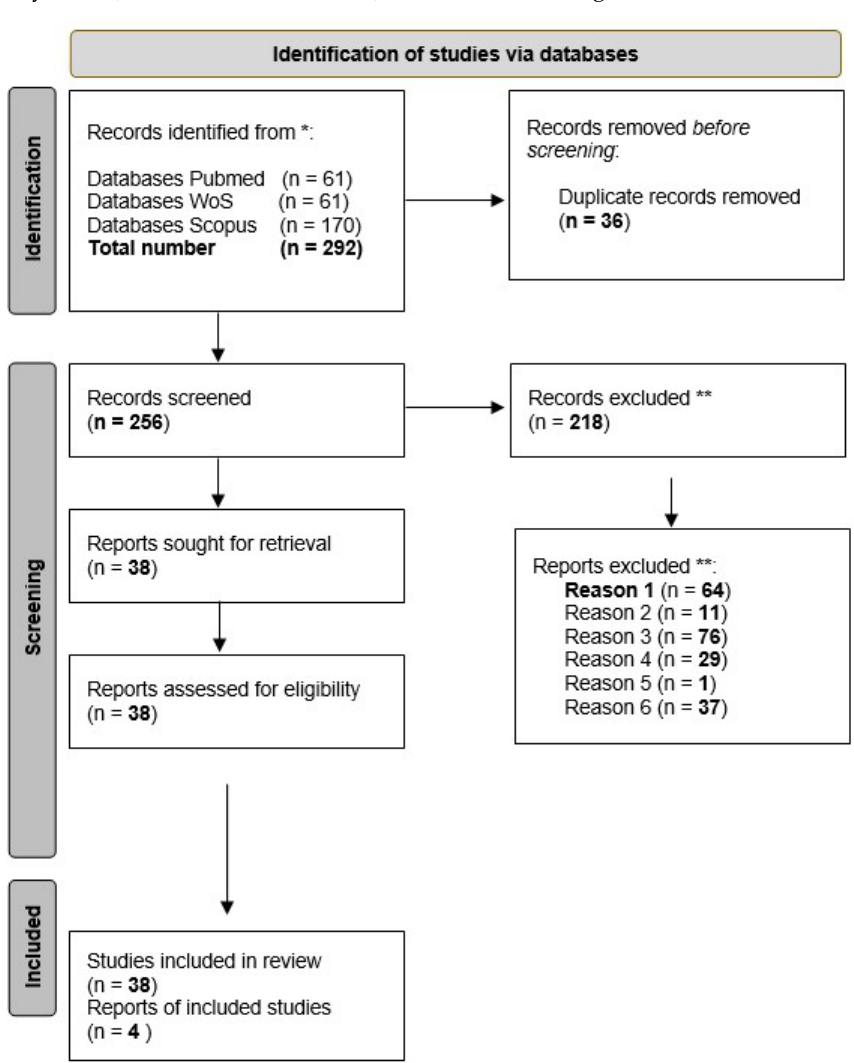
Figure 1. PRISMA 2020 flow diagram. * Number of records identified in each database. ** Ex- clusion criteria: Reason 1, non-Mediterranean plant ( n = 64, ending up in a new initial number of 256 − 64 = 192); Reason 2, review ( n = 11); Reason 3, properties other than antimicrobial § ( n = 76); Reason 4, not plant ( n = 29); Reason 5, not edible ( n = 1); Reason 6, off-topic ( n = 37). § Mainly studies describing the ethnobotanical use of the species against a wide range of non-transmissible diseases (diabetes, hypertension, chronic pain, tumors, etc.). Figure 2020. Statement: an updated guideline for reporting systematic reviews. BMJ 2021; 372: n71. doi:10.1136/bmj.